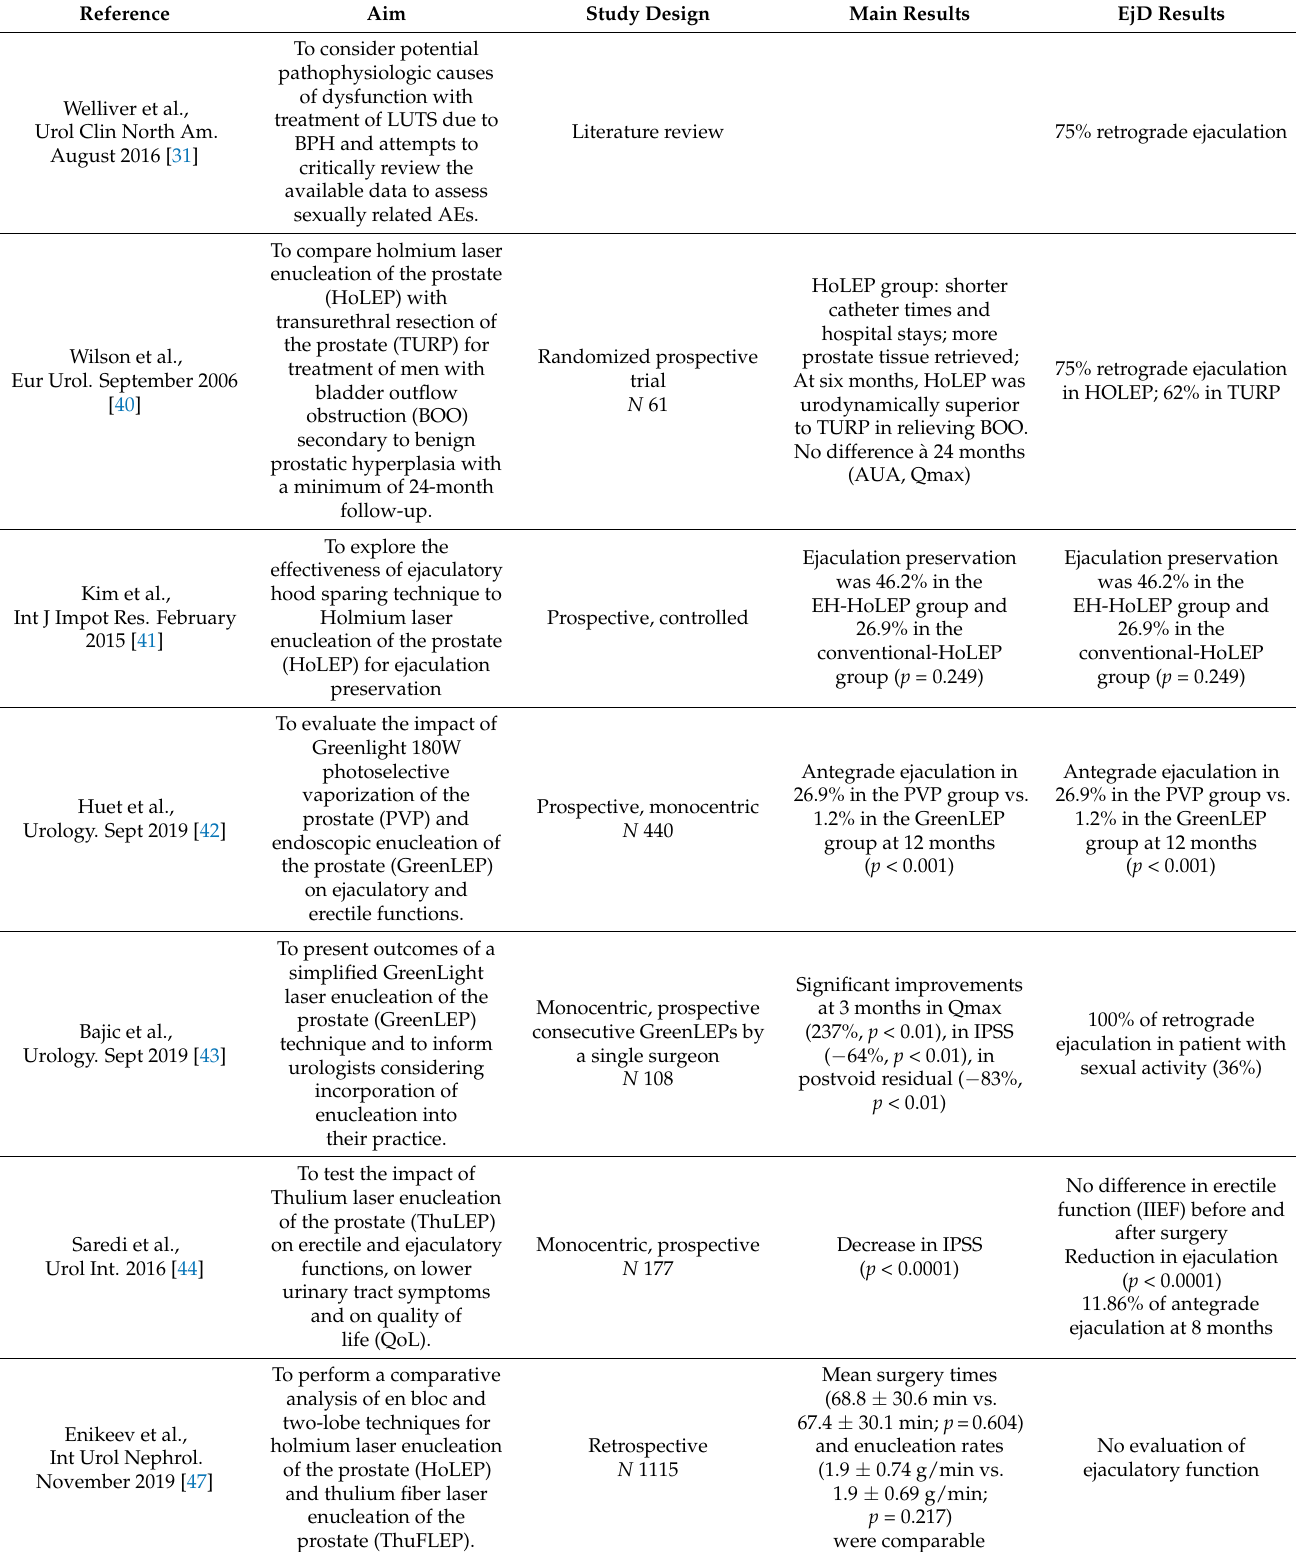
Table 7. Impact of anatomic endoscopic enucleation of Prostate on the ejaculatory